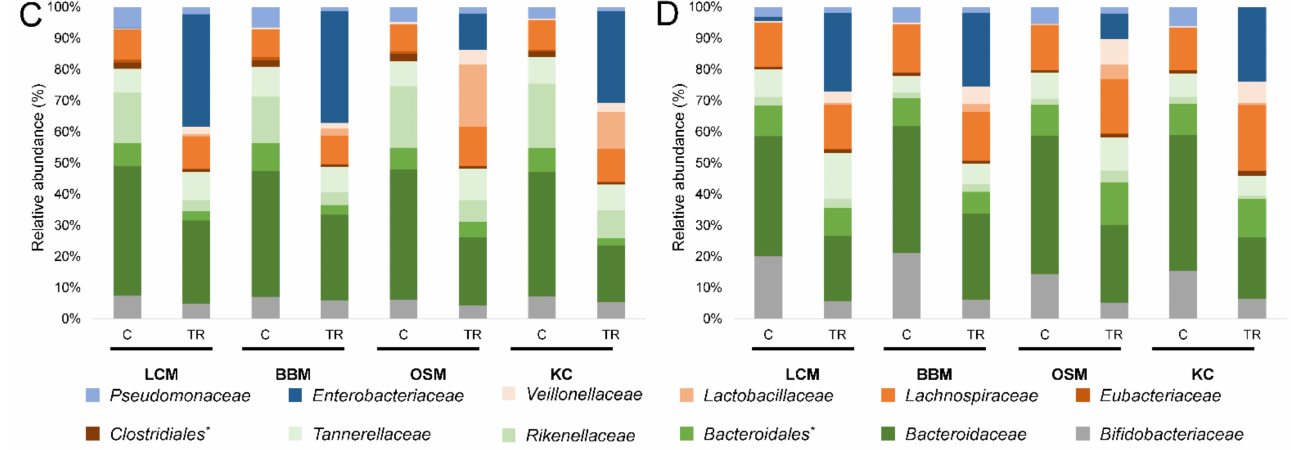
Figure 4. Changes in microbial community composition (relative abundance) at the family level in the luminal PC and DC for ( A ) Donor A, luminal PC; ( B ) Donor B, luminal PC; ( C ) Donor A, luminal DC; ( D ) Donor B, luminal DC. * Unidentified family. BBM = Berry Blast Muffin; C = control period; DC = distal colon; KC = Kodiak Cake; LCM = Lemon Chia Muffin; OSM = Oat Spice Mookie; PC = proximal colon; TR = treatment